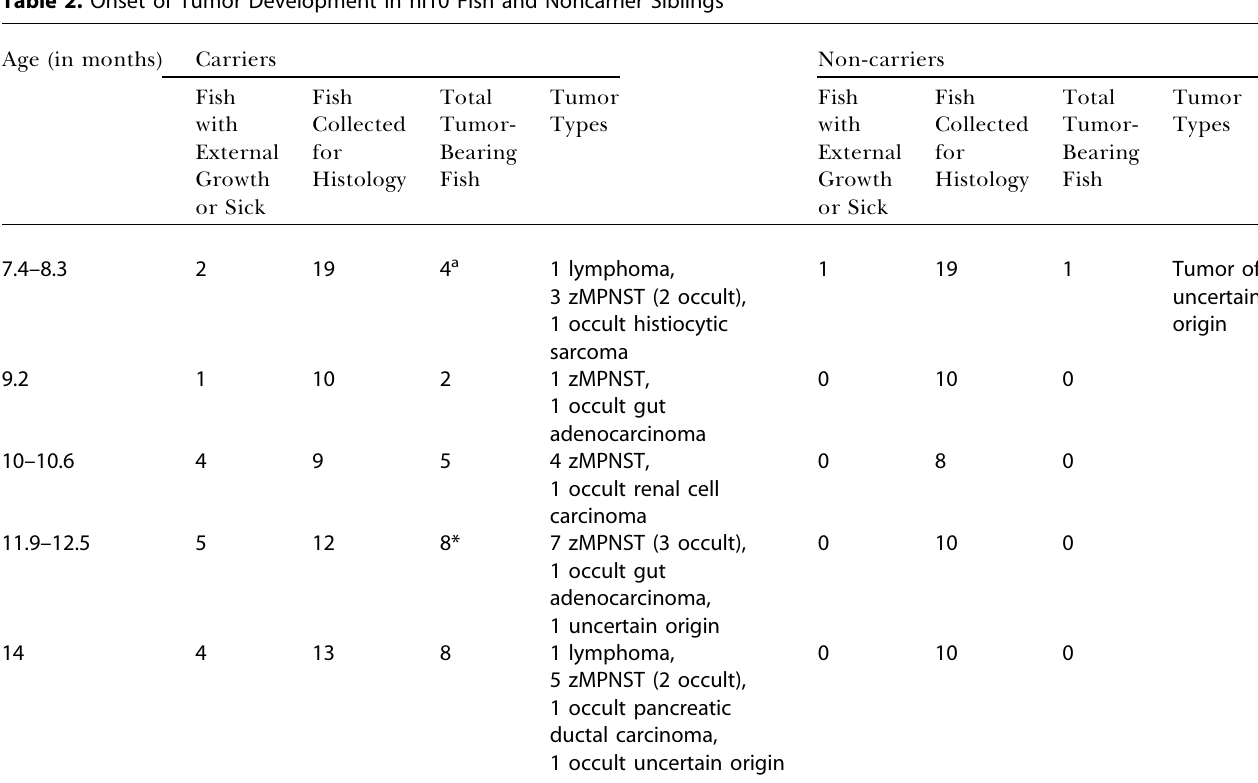
Figure 3. Rate of Tumor Appearance in hi10 Heterozygotes A cohort of 28 hi10 fish and 13 of their noncarrier siblings were observed over 22 mo for the appearance of ill health or externally visible tumors. Symptomatic individuals were sacrificed, fixed, and sectioned for histological analysis. The graph represents the percentage of fish remaining over time, with the diagnosis of each removed fish. Three fish labeled ‘‘ dead ’’ died before fixation and had too much tissue damage to establish a diagnosis. Also, seven of the carrier fish (though none of the noncarriers) were lost to unknown causes over the course of the experiment; while they most likely died, to be conservative these were removed from the total number of fish charted. At 22 mo, the remaining exter- nally healthy fish (4/21 carriers, 13/13 noncarriers) were also histologically ex- amined, and the status of these fish is indicated.